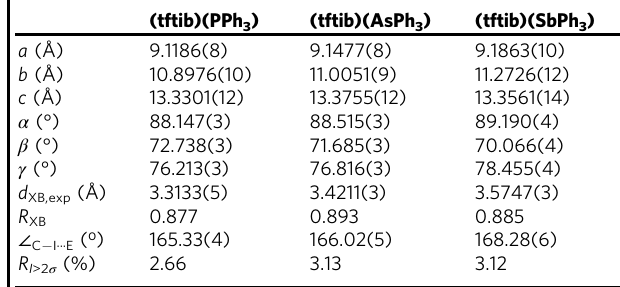
Table 1 Crystallographic parameters, XB distances, angles, R R I >2 σ for (tftib)(PPh 3 ), (tftib)(AsPh 3 ) and (tftib) XB and (SbPh 3 ), determined at 103